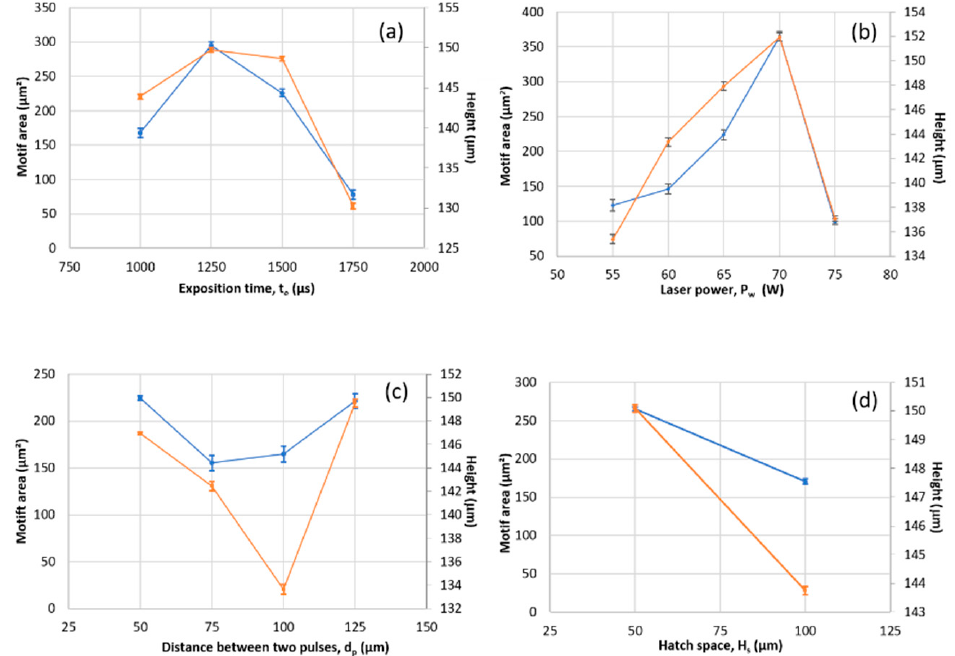
Figure 16. Results of the two variance analyses of all the process parameters: ( a ) Exposition time, ( b ) laser power, and ( c ) distance between two pulses and ( d ) Hatch space. Orange Curves represent the motif area and the blue curves represent the motif height.